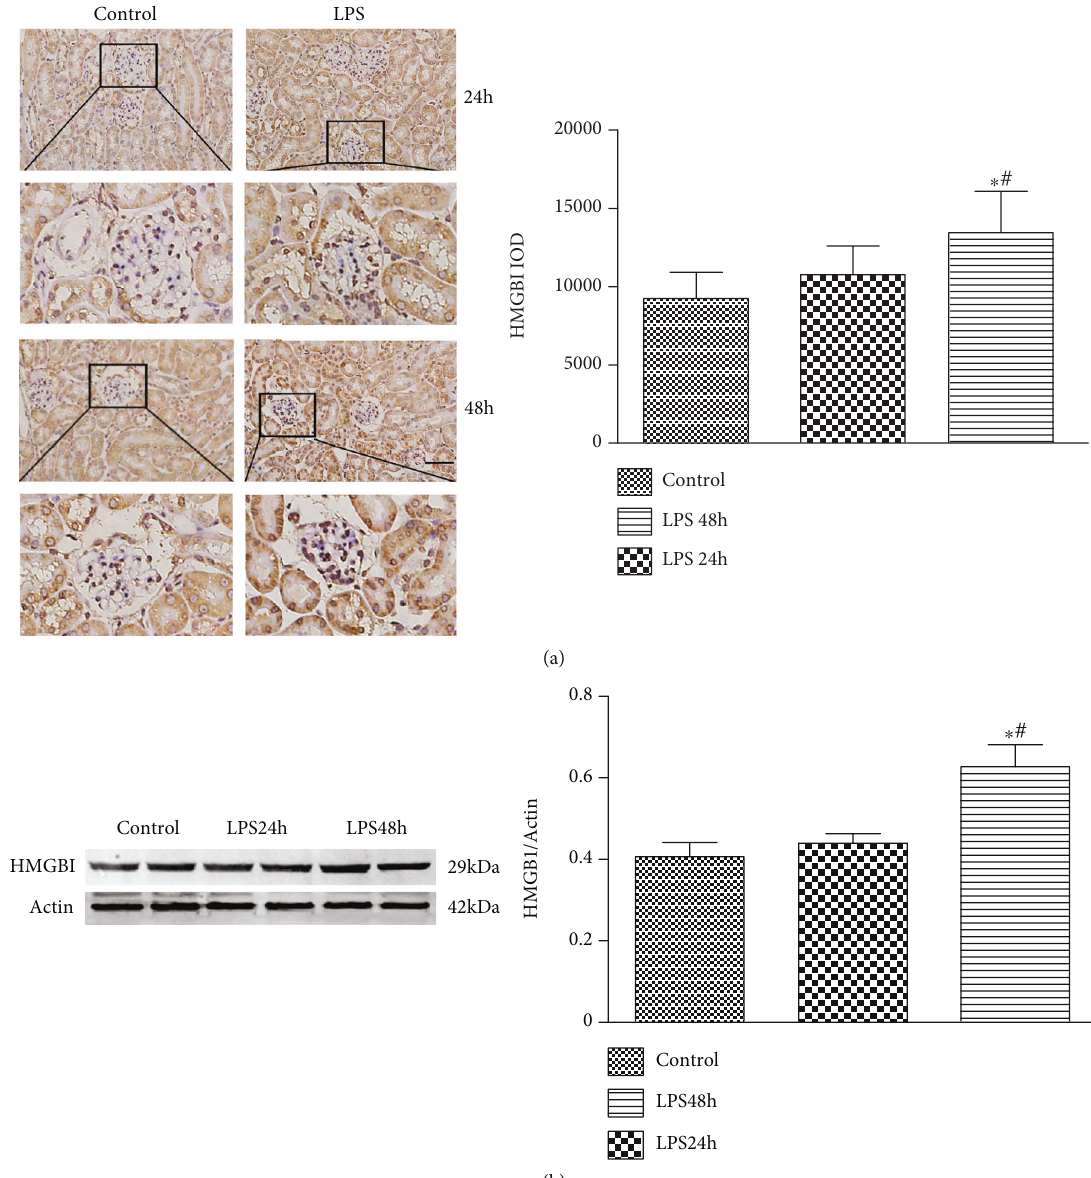
Figure 2: The level of HMGB1 is increased in the kidney of AKI mice. (a) Representative IHC image of HMGB1 expression in both groups after the LPS challenge. (b) Representative Western blotting analysis image of HMGB1 expression in both groups after the LPS challenge. Scale bars 50 μ m. ∗ P < 0 : 05 compared with the control group; # P < 0 : 05 compared with LPS 24h